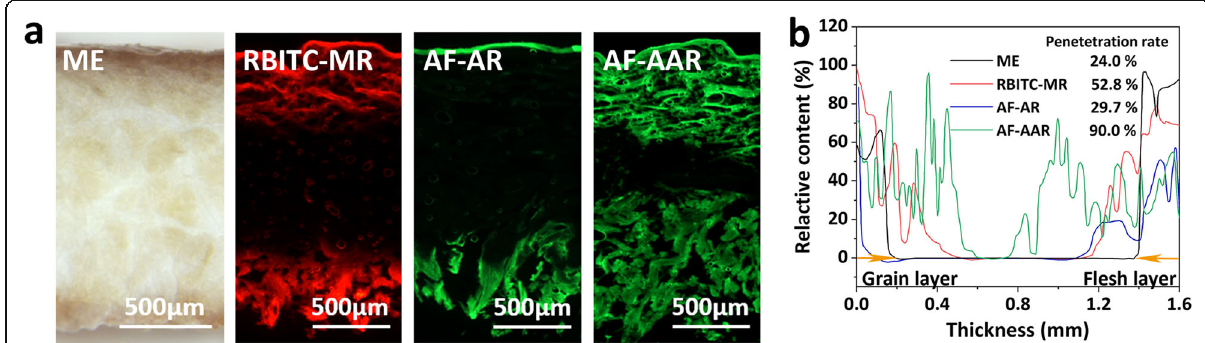
Fig. 4 a Stereo micrograph and fluorescence micrographs of cross-sections of wet white retanned with single retanning agent; ( b ) relative contents and penetration rates of the retanning agents obtained by analysis of ( a ) using Image J